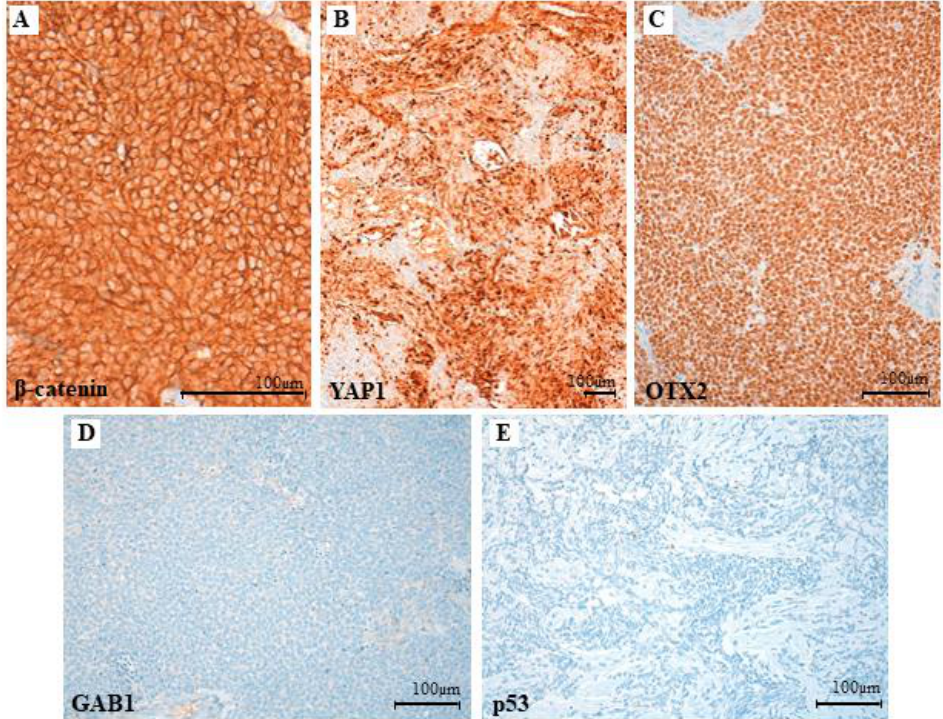
Figure 5. Immunostaining of tumor specimen. The immunoprofile shows patchy nuclear staining for β -catenin ( A ): 400 × magnification, diffuse nuclear stain for YAP1 ( B ): 100 × magnification and OTX2 ( C ): 200 × magnification, and negative staining for GAB1 ( D ): 200 × magnification and p53 ( E ): 200 × magnification.